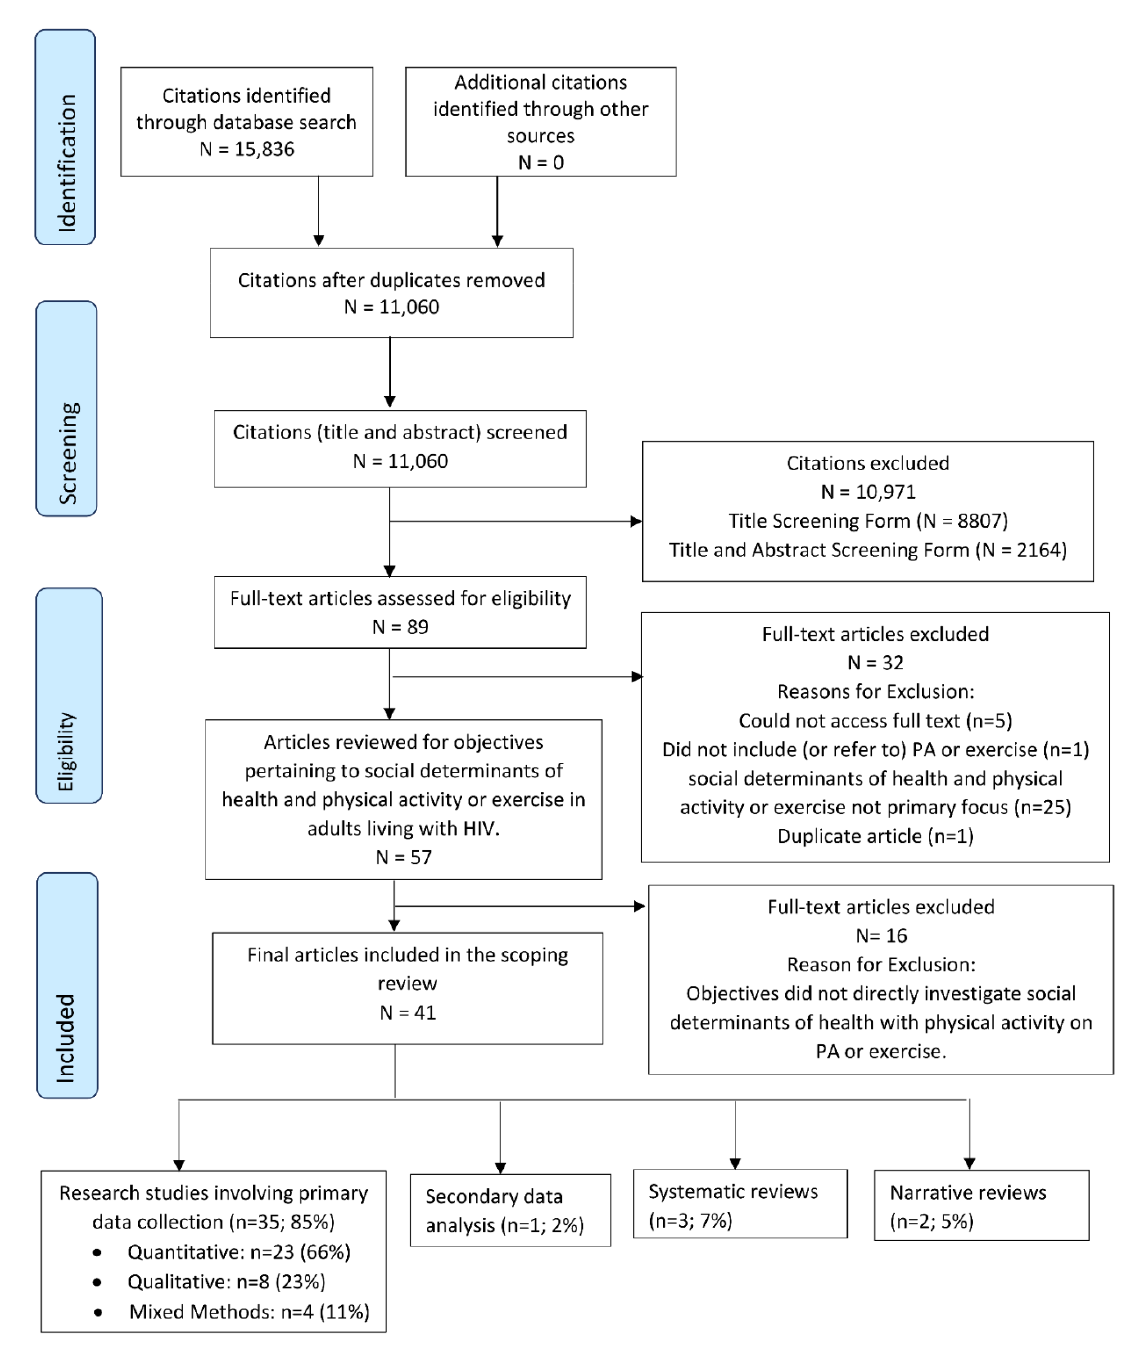
Figure 1. PRISMA Flow Diagram—Scoping Review: Evidence on Social Determinants of Health, Physical Activity or Exercise among Adults Living with HIV.